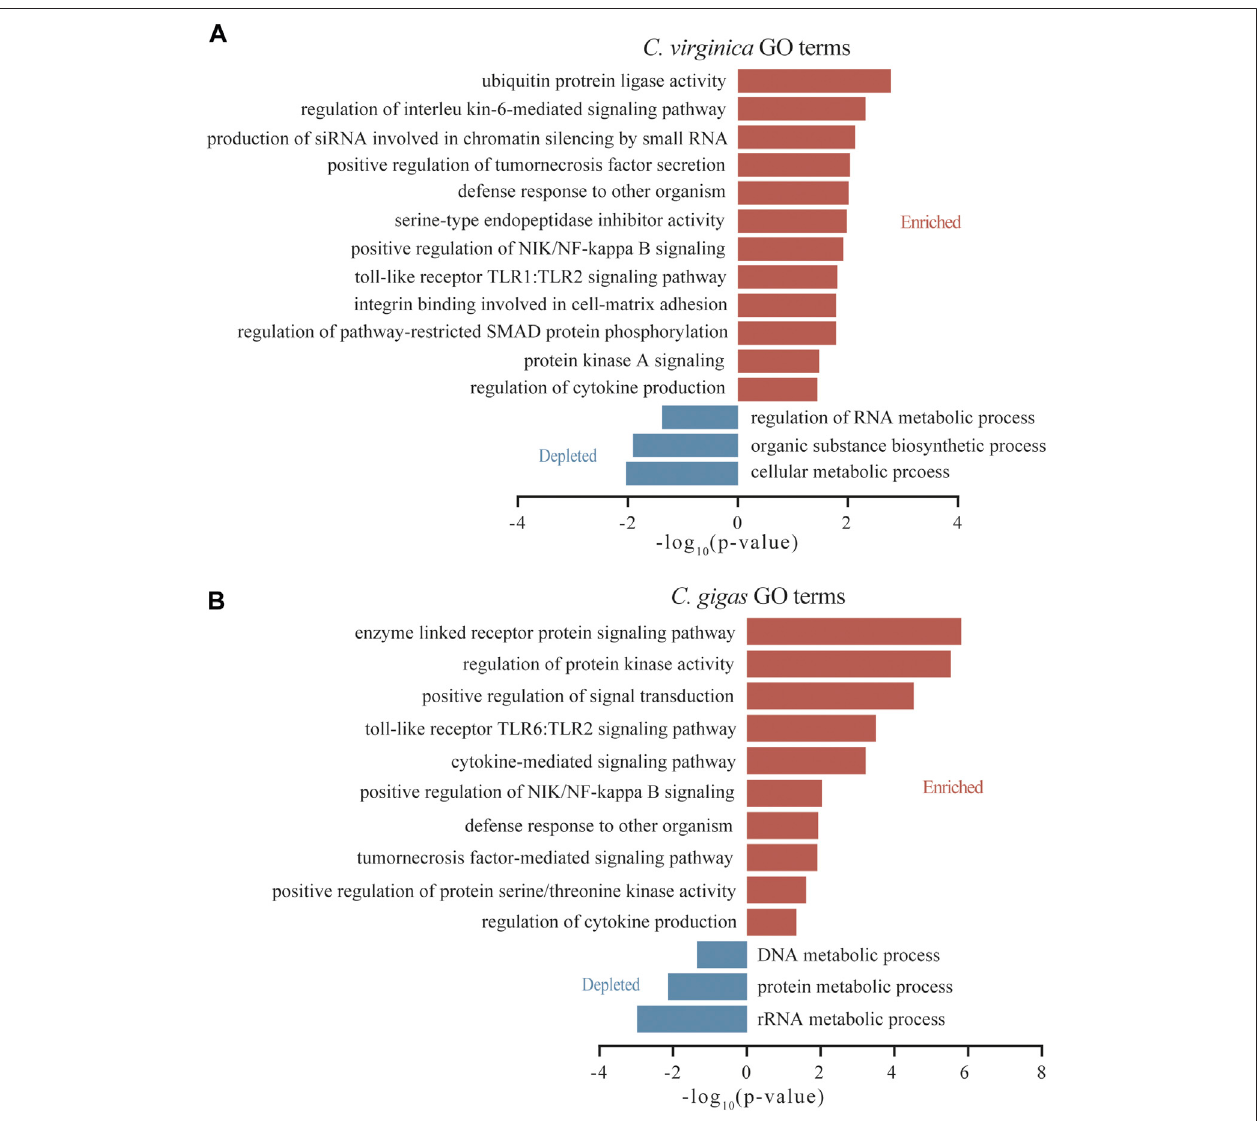
FIGURE 4 | GO enrichment analysis of the differentially expressed genes after Dermo challenge between C. virginica (A) and C. gigas (B) . Red and blue columns represent functional enrichments of up-regulated and down-regulated genes, respectively.